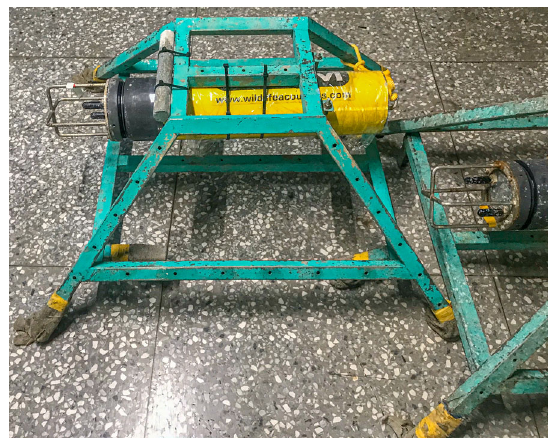
Fig. 6 Setup of the SM3M submersible recorder. SM3M recorder fastened to the steel frame (length and breadth = 1.22 m, height = 0.52 m) with plastic cable zip ties prior to deployment.